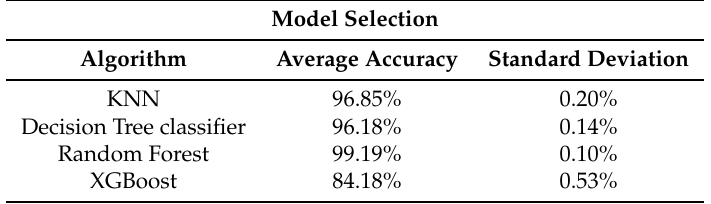
Table 4. Comparison of different machine learning algorithms.